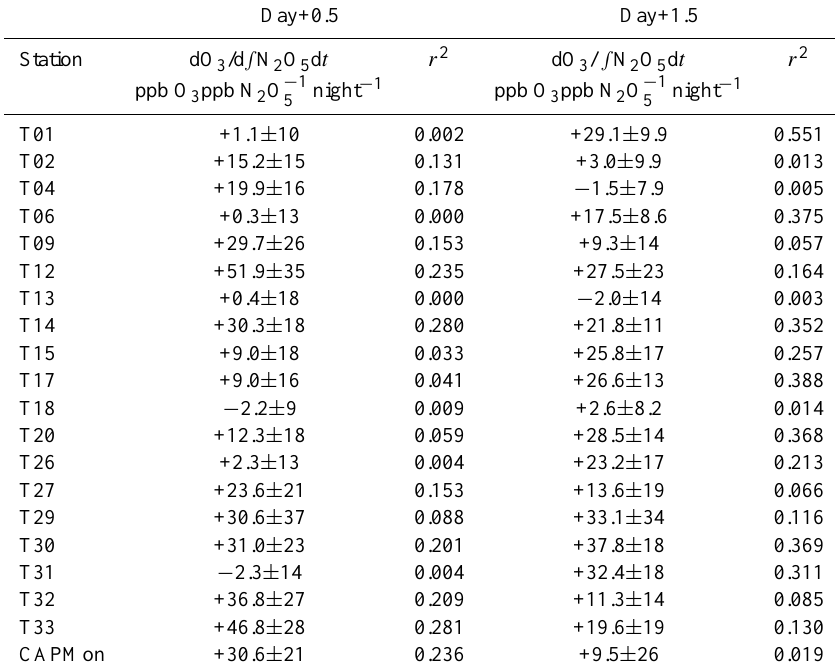
Table 2. Correlation between ∫ N 2 O 5 dt measured overnight at Saturna Island and maximum 1-h ozone measured at air monitoring stations in the LFV the next day (DAY + 0.5) and the day after that (Day + 1.5).